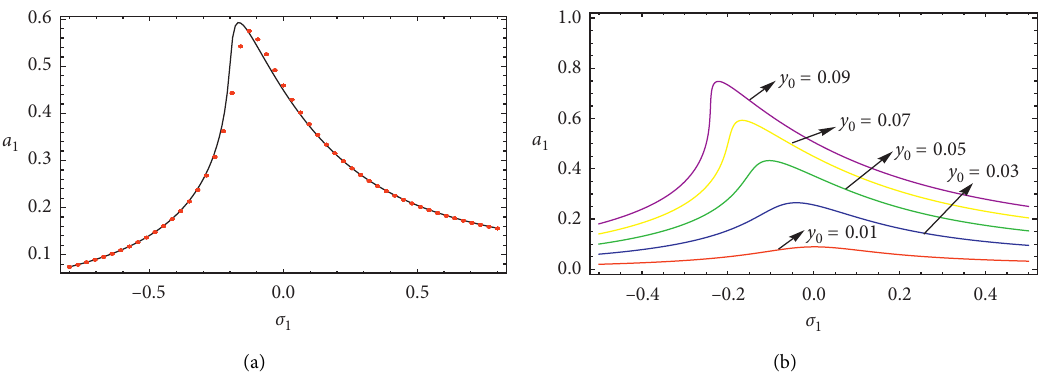
Figure 11: Response curves of the uncontrolled beam. (a) Comparison between numerical solutions and approximate solutions when y � 0 . 07; (b) effect of y on the response curves. 0 0